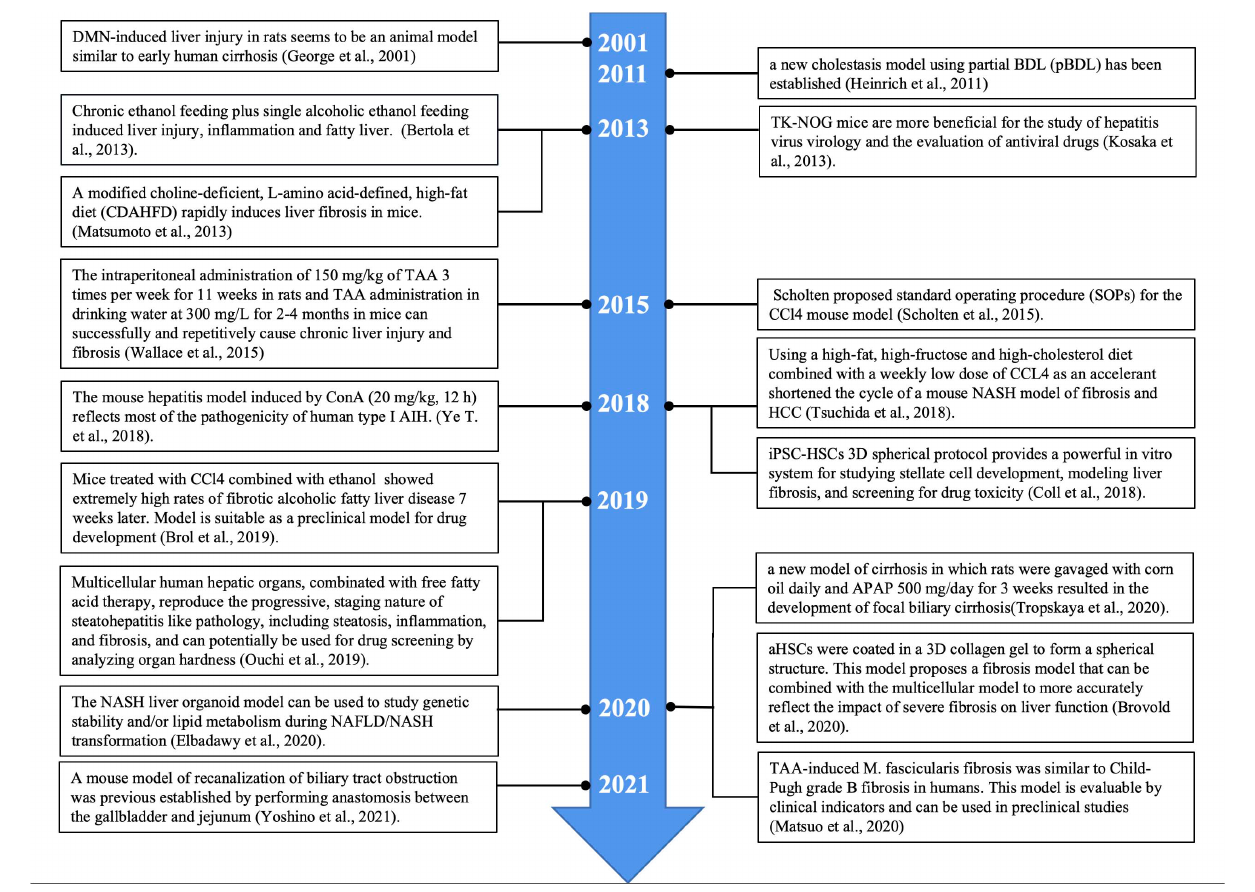
FIGURE 3 | Timeline of animal and organoid liver fibrosis